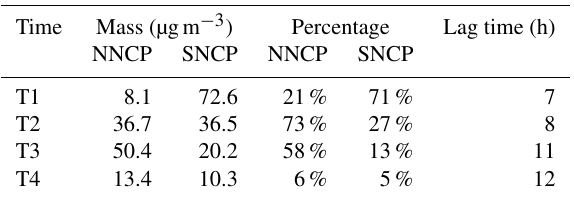
Table 6. The regional average contribution of CFB in mass concen- tration and percentage, and the time lag of NNCP to SNCP for the four time points of T1 (23:00, 6 Oct), T2 (05:00, 7 Oct), T3 (20:00, 7 Oct) and T4 (19:00, 8 Oct).